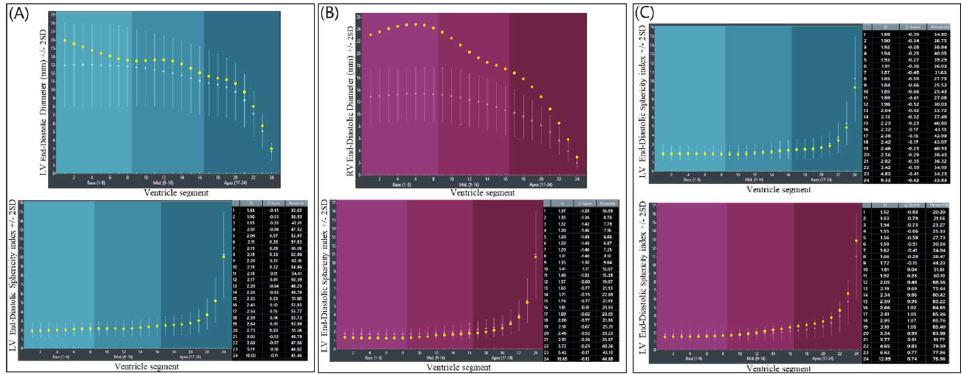
Figure 4. Twenty-four-segment ventricular analysis and the 24-segment sphericity index at a GA 35 +2 . ( A ) LV geometry of the fetus with CVD. The upper graph shows the results of the 24-segment ventricular analysis. The lower graph shows the results of the 24-segment sphericity index analysis. ( B ) RV geometry of the fetus with CVD. The upper graph shows the results of the 24-segment ventricular analysis. The lower graph shows the results of the 24-segment sphericity index analysis. The RV was wider than the reference value and was particularly prominent at the base (1-8) and mid (9- 16) regions, the widths of which were out of range. ( C ) Twenty-four-segment sphericity indices of the healthy fetus. All measurements were above the 10th percentile. LV, left ventricle; Rt, right; RV, right ventricle; SD; standard deviation.